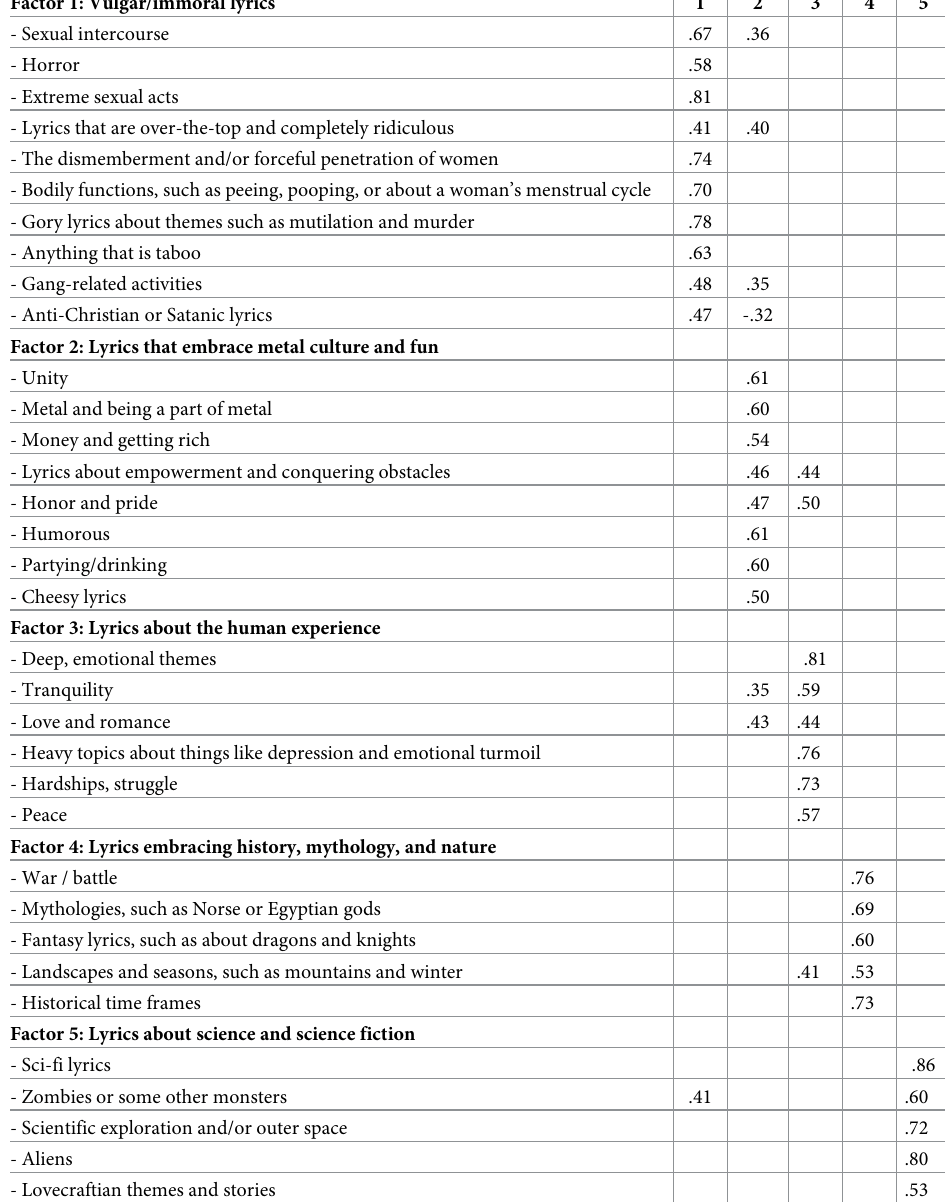
Table 2. Factor items & factor loading for lyrical preferences.